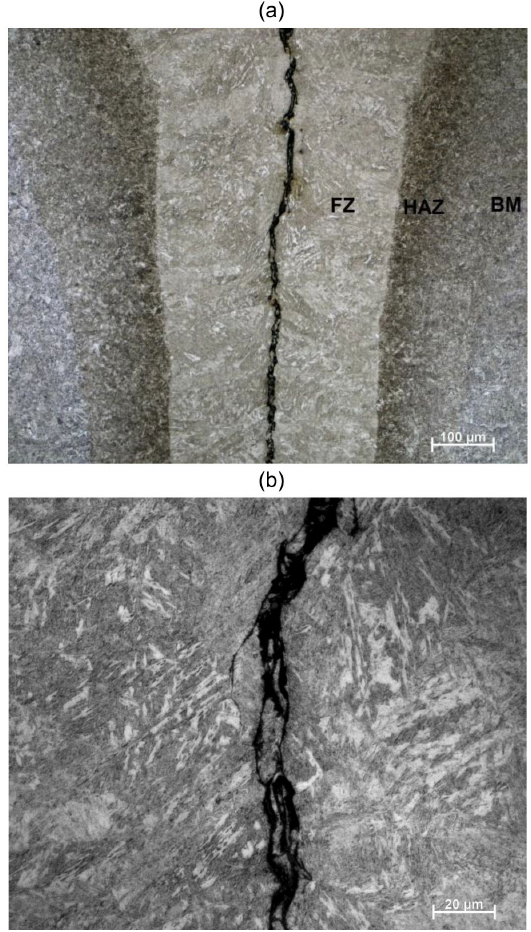
Figure 6. (a) Optical microscopy (Nital etch) of the RT weld. (b) a close look in